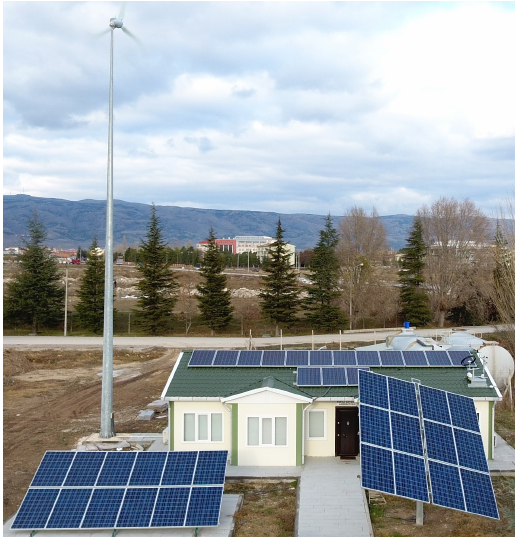
Figure 1. The Renewable Energy Research Home (RERH) at Anadolu University ˙Iki Eylul Campus in Eski¸sehir,